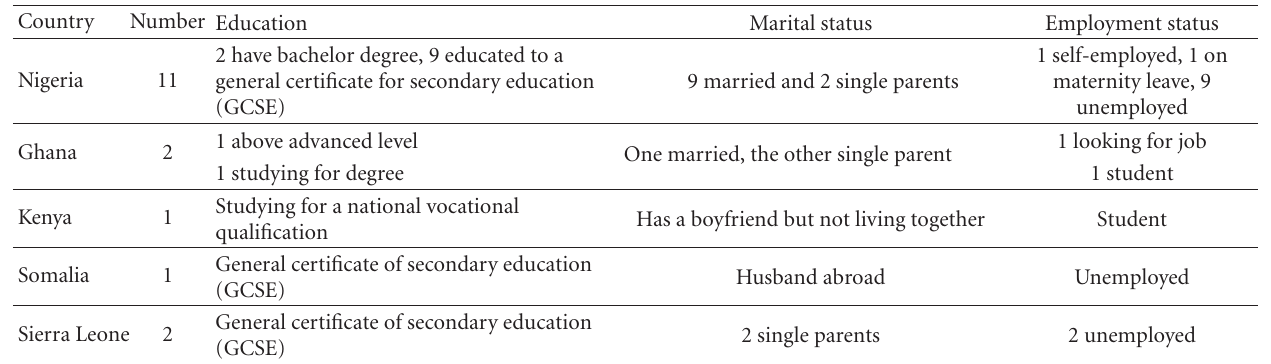
Table 1: Participants’ socio-demographic